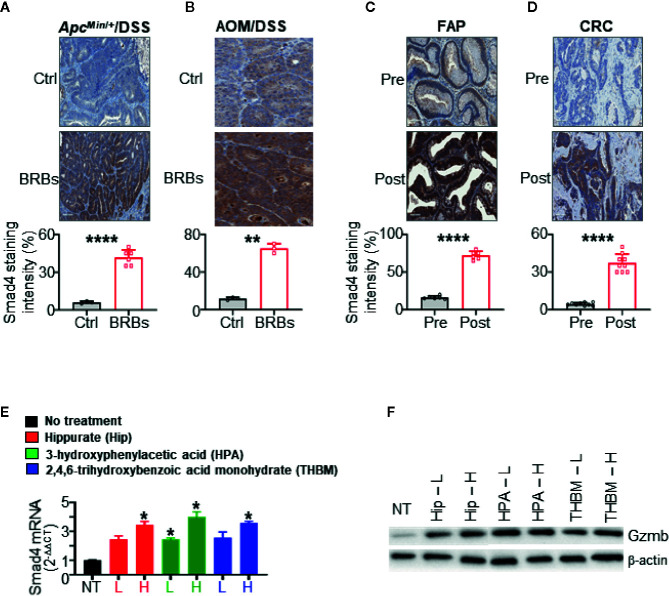
Black raspberries (BRBs) increased Smad4 expression in colorectal cancer (CRC) mouse models and primary colon specimens. Representative immunohistochemistry (IHC) images and quantitative staining of Smad4 in colon sections from (A)
ApcMin
/+ mice treated overnight with dextran sulfate sodium (DSS) and (B) mice treated with azoxymethane (AOM) followed by overnight DSS. The mice were fed control (Ctrl) or BRB diets. Representative IHC images and quantitative staining of Smad4 in sections of (C) colon adenoma from FAP patients (n=6) and (D) colon adenocarcinoma from CRC patients (n=9). The circles and squares on the bar graphs denote data from individual specimens. Benzoate metabolites from consumed BRBs upregulate Smad4 mRNA expression (E), Gzmb protein expression (F) in primary human NK cells (n=5 human donors). NT, no treatment, L, low, 100 nM, H, high, 1 µM. *P < 0.05; **P < 0.01; ****P < 0.0001.